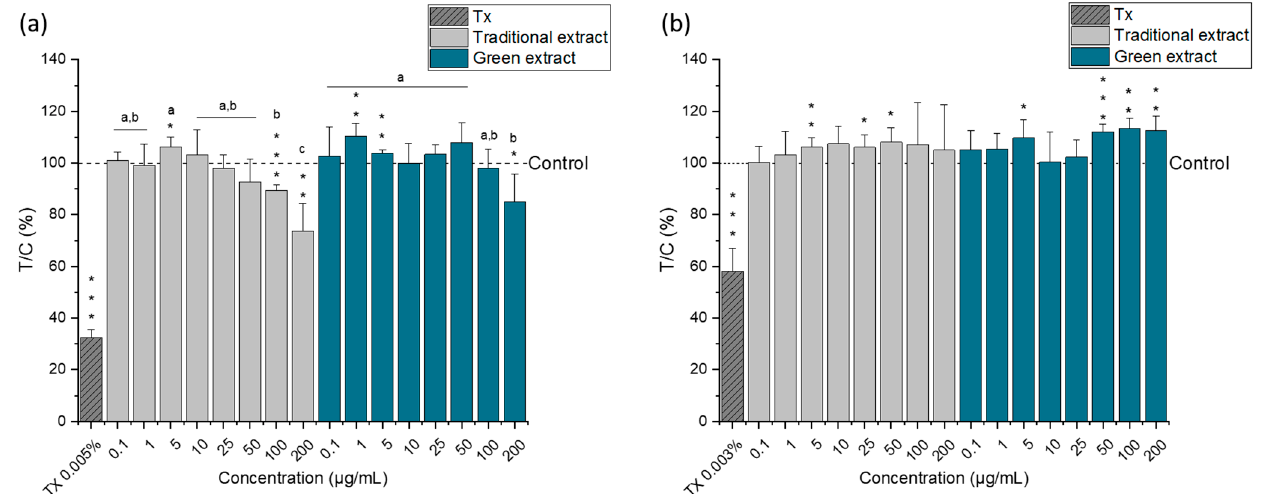
Figure 3. Cell viability of HCT-116 cells ( a ) and HCEC-1CT ( b ) after 24 h incubation with different concentrations of the omega-3 lipid extracts produced by the traditional method (traditional extract) and the green method by using Saczyme (green extract) measured by CTB assay. Triton X (Tx; 0.005 or 0.003%) was used as positive control. Results are presented as mean + SD normalized to DMSO solvent control (0.5%; T/C in %) (n = 6). Statistical differences compared to the DMSO solvent control were calculated with a one-sample Student’s t -test (* p , ** p , *** p < 0.05, 0.01, 0.001). Significant